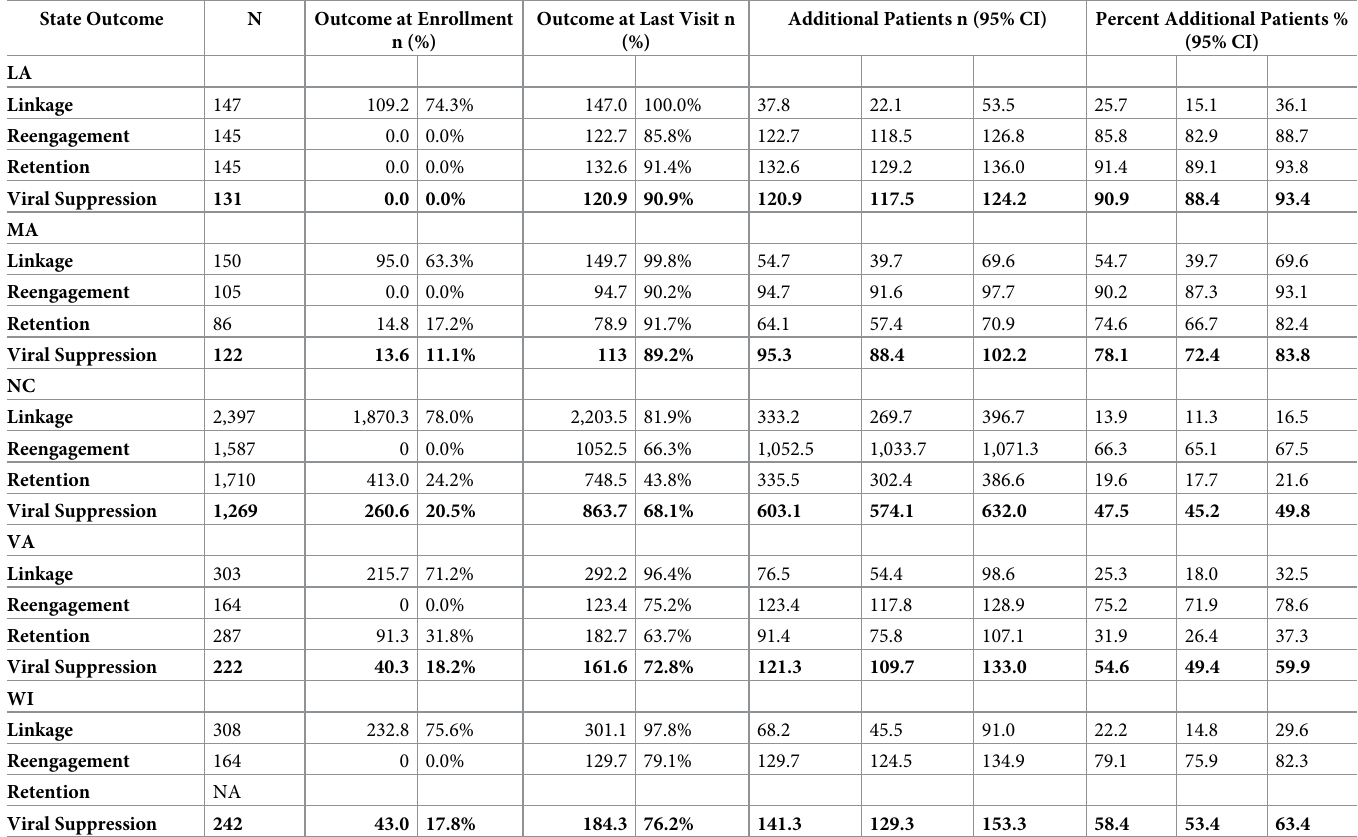
Table 2. Estimated number and percent additional patients linked, reengaged, retained, and virally suppressed by 12 months (using inverse probability weighting to adjust for differences in patient populations and